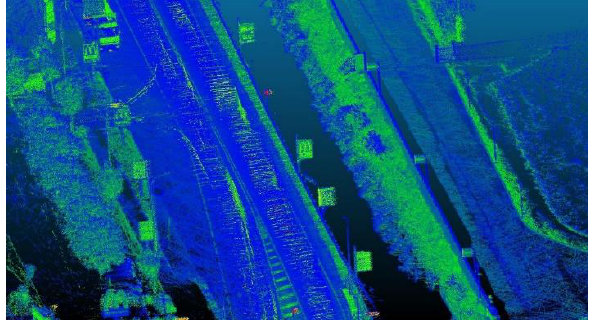
Figure 10. 3D point cloud by Kaarta Stencil 2 obtained surveying Via